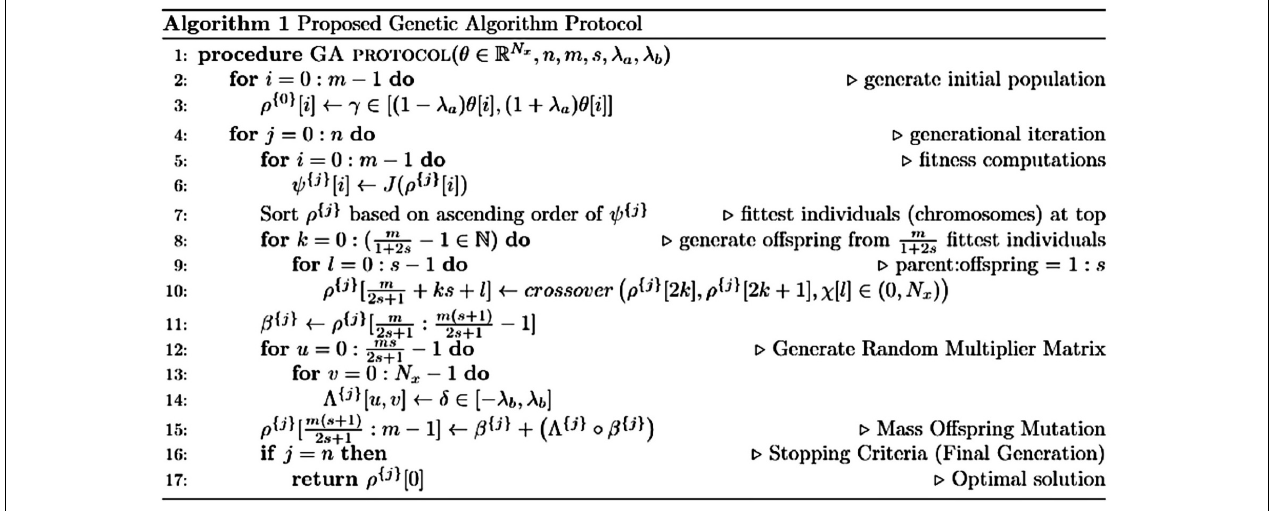
FIGURE 3 | Algorithmic description of the genetic algorithm (GA) protocol used in fitting the ionic currents. θ : original model chromosome; θ [ i ] : original model gene; N x : chromosomal length/number of genes; m : population size; s : offspring proportion (parent-offspring ratio = 1 : s ); J () : loss function (SSE or RMSE); λ a : initial population constraint; λ b : mutation constraint; and χ : an iterable comprising lists of crossover point(s). Length ( χ [ i ] ) ∈ ( 0 , s ] . All intervals [i.e., [a, b], (a, b] or (a, b)] are uniformly distributed. Parameters belonging to these intervals were randomly